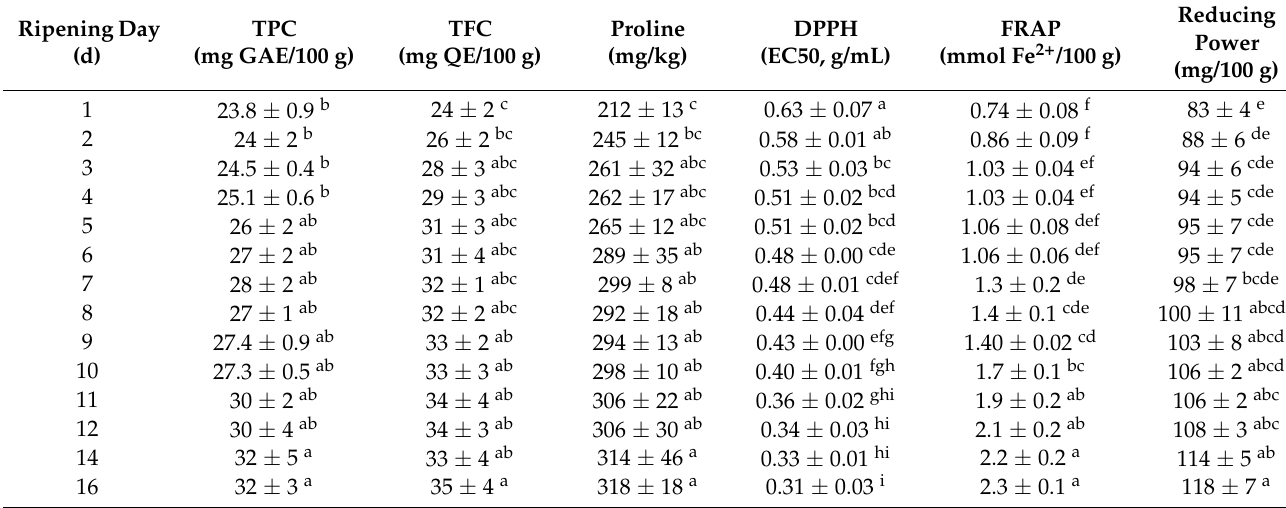
Data represent the mean of triplicate readings ± standard deviations (SD). GAE: gallic acid. QE: quercetin. TPC: total phenolic content. TFC: total flavonoids content. FRAP: ferric reducing/antioxidant power. Different lower case letters correspond to significant differences at p < 0.05.